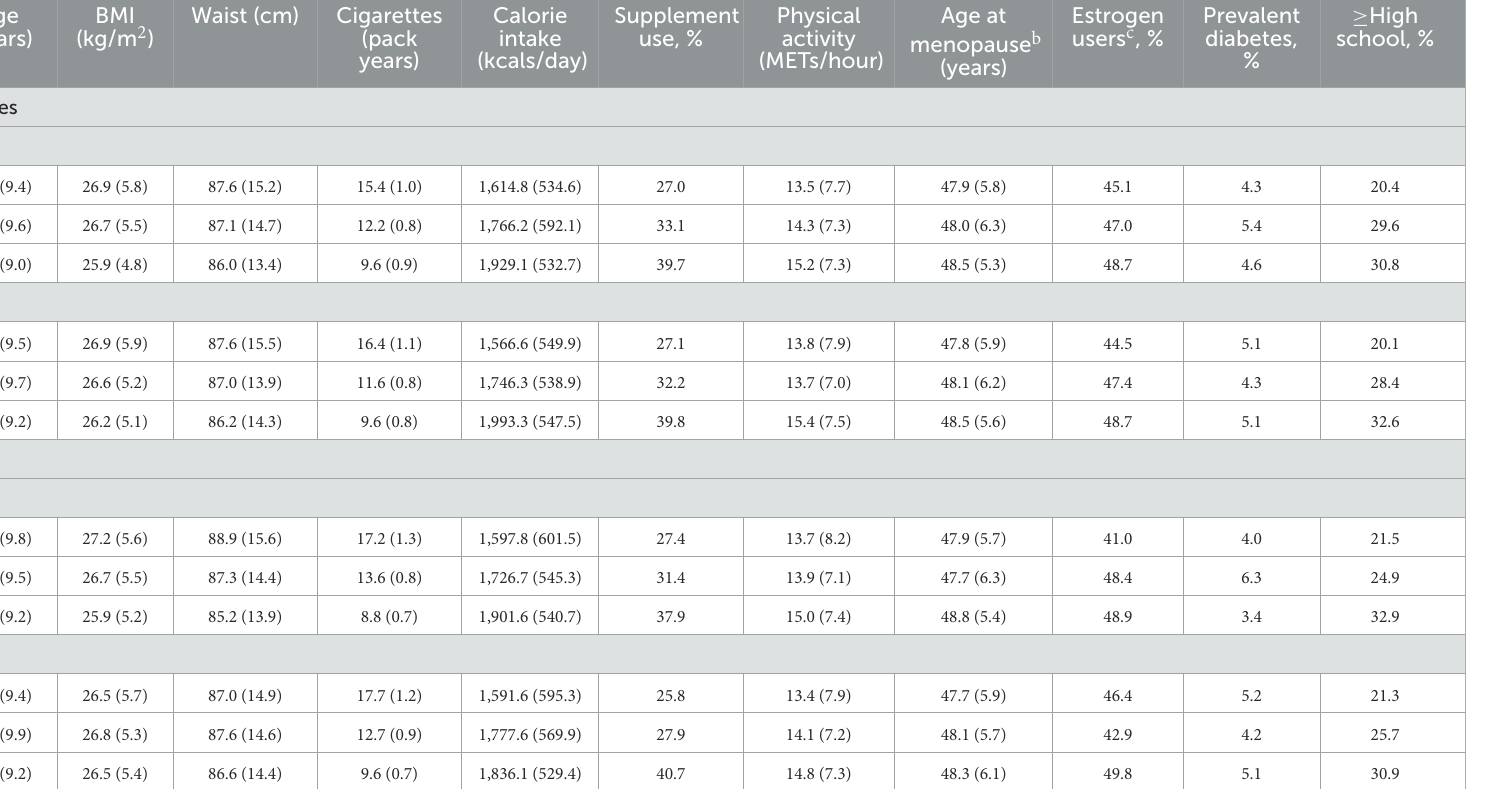
TABLE 2 Baseline characteristics a across the score categories of Mediterranean diet indices in women of the Framingham Offspring Study. Mediterranean diet indices